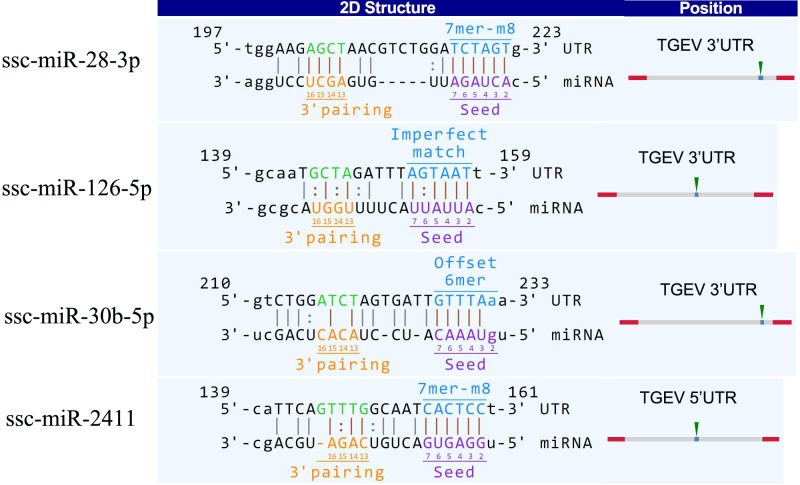
Differentially expressed miRNAs directly targeted the 3' UTR or 5' UTR of the TGEV genome.ssc-miR-28–3p, ssc-miR-126–5p and ssc-miR-30b-5p target the 3' UTR of the TGEV genome (28297 bp–28571 bp), ssc-miR-2411 target the 5' UTR of the TGEV genome (1 bp–303 bp).